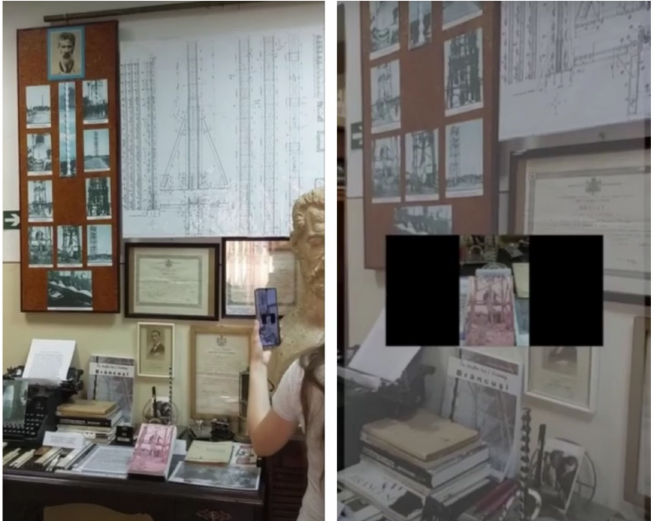
Figure 8. Piloting the beacon-based localization: a screenshot from an external video, filming the real scene and the visitor’s phone ( left ) and a screen capture of the phone, displaying a video with general information about that room, in the center, superimposed on the video stream from the phone’s camera ( right ).